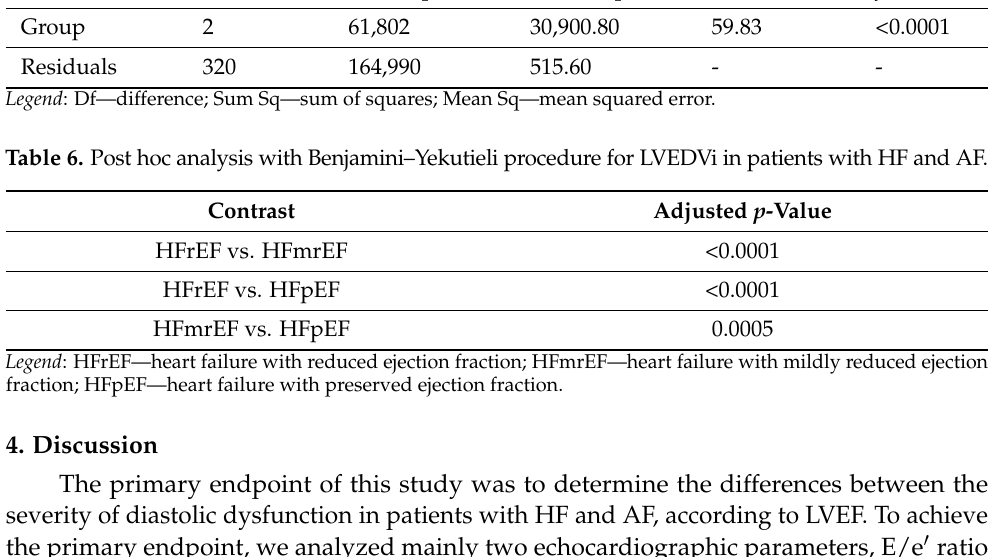
Table 5. Analysis of variance (ANOVA) for LVEDVi in patients with HF and AF. Source Df Sum Sq Mean Sq F Stat. Group Residuals 320